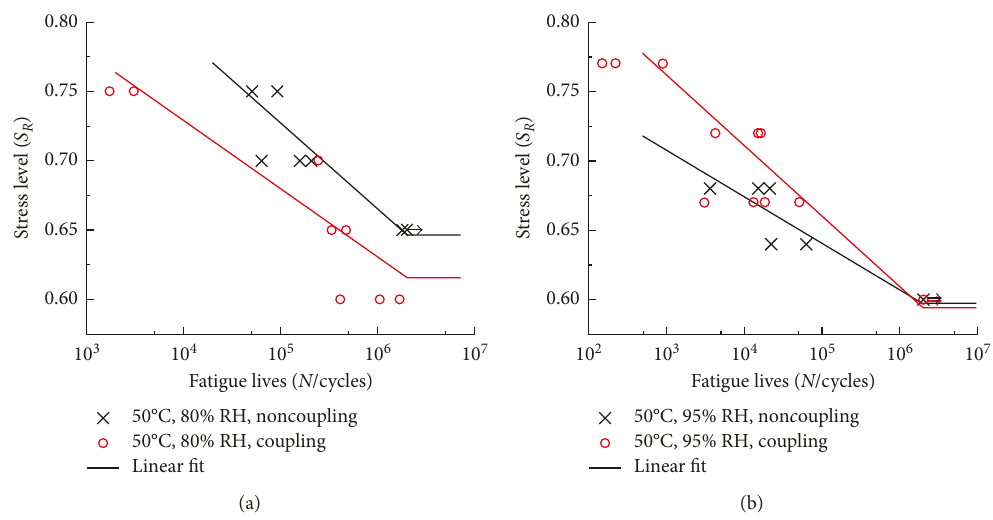
Figure 6: Influence of the experimental method on S